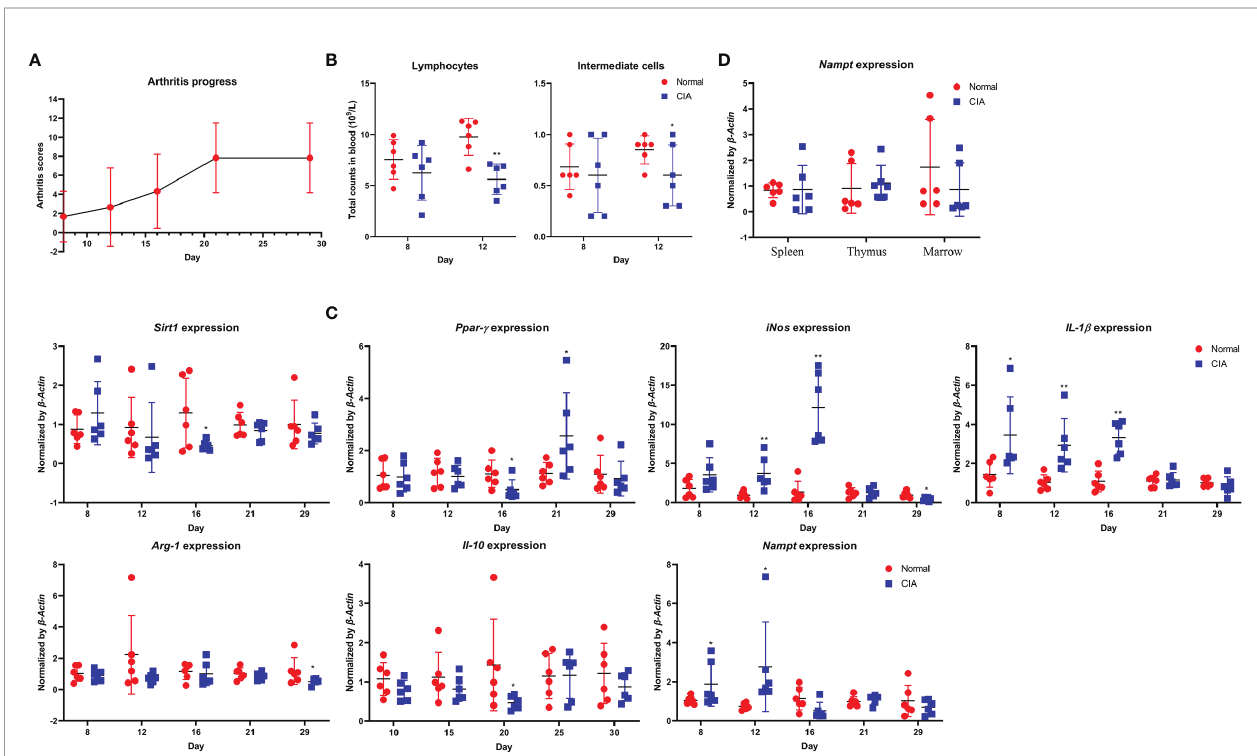
FIGURE 2 | Validation of periodic changes in CIA using male Wistar rats housed in SPF laboratory. (A) periodic changes of arthritis scores; (B) decrease in lymphocyte and intermediate cell counts observed during early CIA; (C) periodic mRNA expression of Nampt and monocytes polarization-related genes in peripheral WBCs; (D) mRNA expression of Nampt in main immune organs of rats when sacri fi ced. Statistical signi fi cance: *p < 0.05 and **p < 0.01 compared with normal healthy